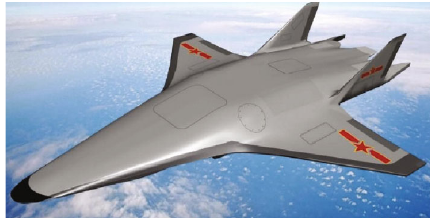
Figure 1: Sketch map of a hypersonic glide vehicle with the “ boost +glide ”